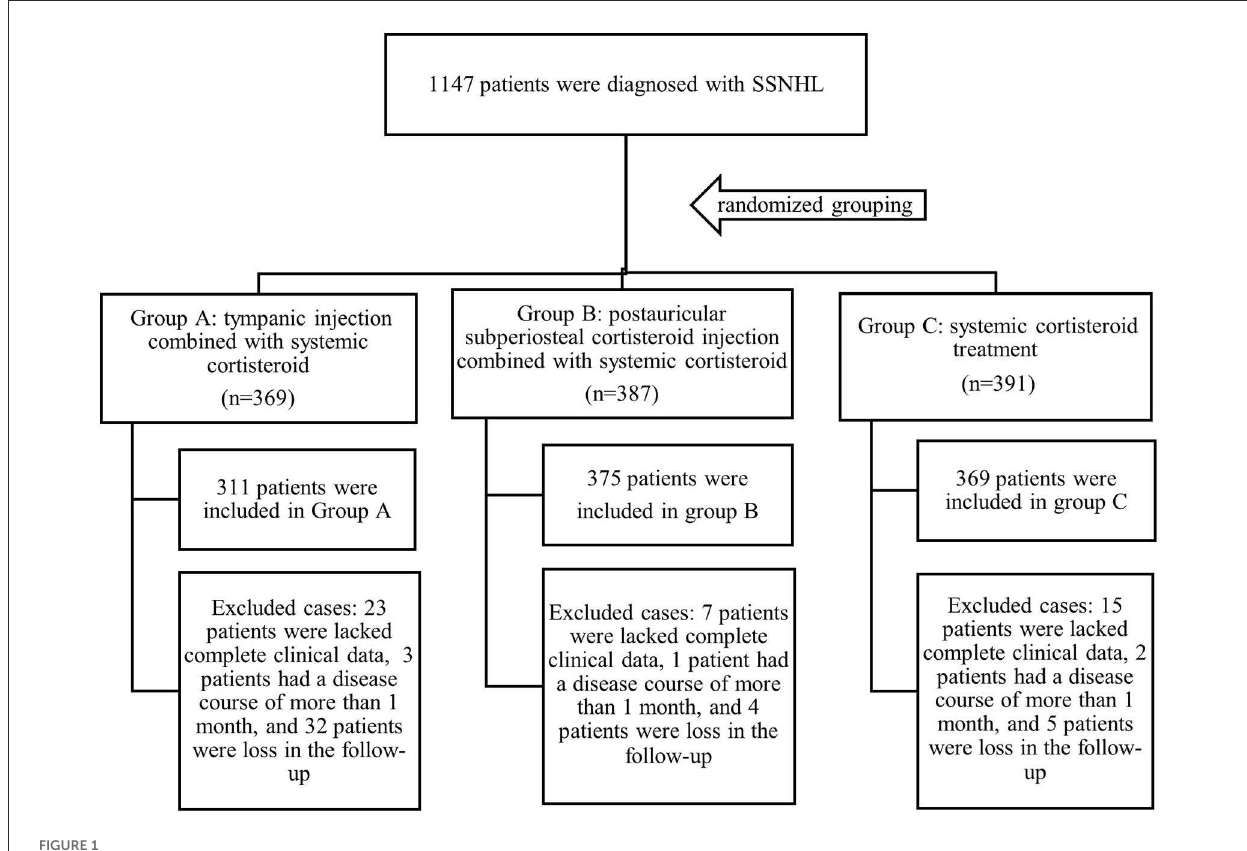
FIGURE1 Flow gram of the study.